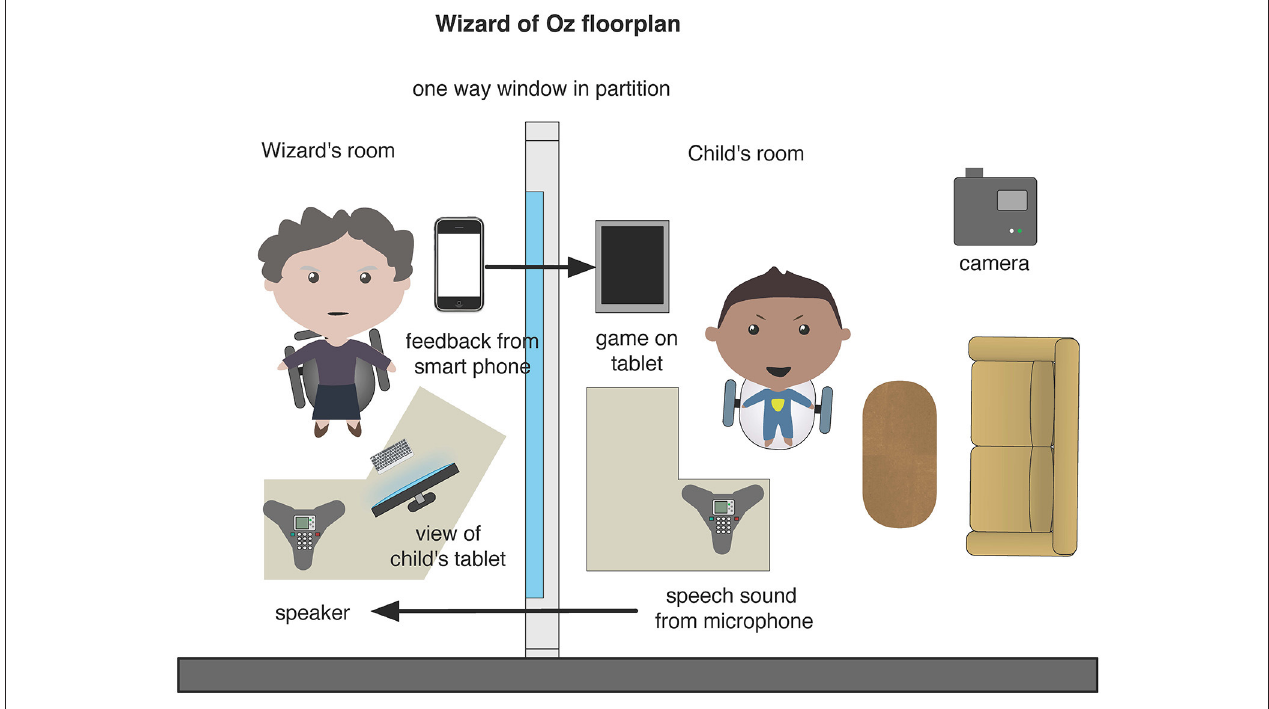
FIGURE 1 | “Wizard of Oz” setup.